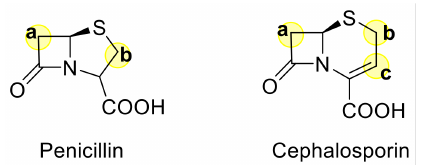
Figure 1. Modification sites for attaching spirocyclic